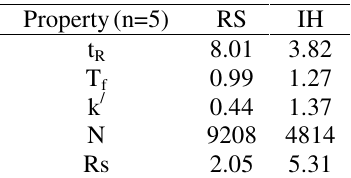
Table 5. System suitability study.